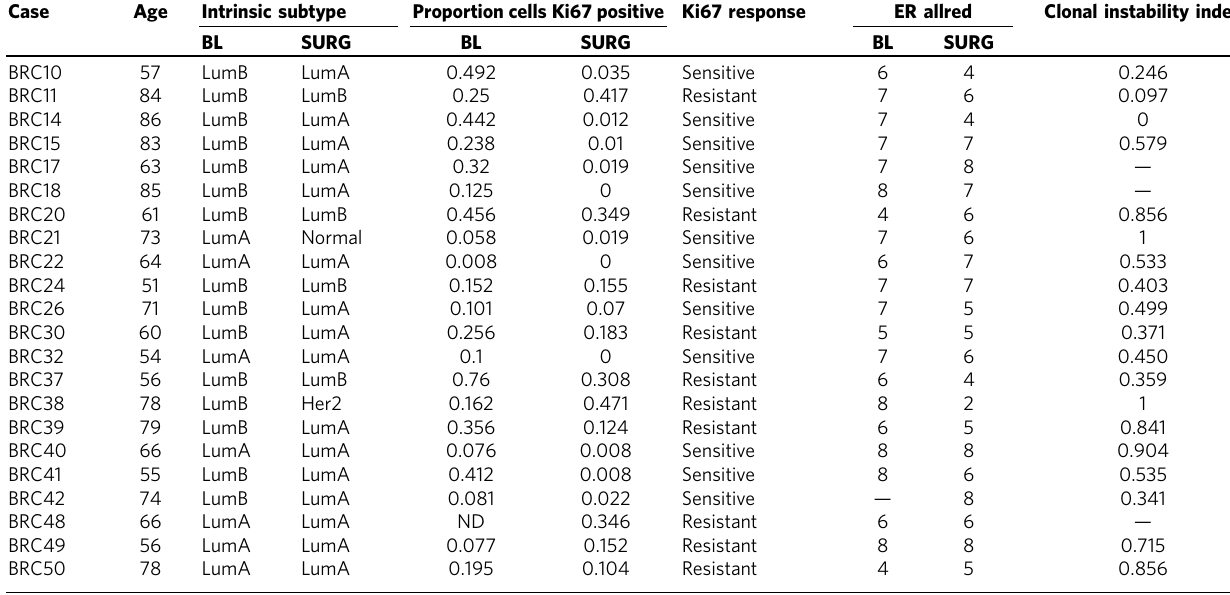
Table 1 | Samples whole-genome sequenced in this study and a description of key clinical and biomarker parameters.